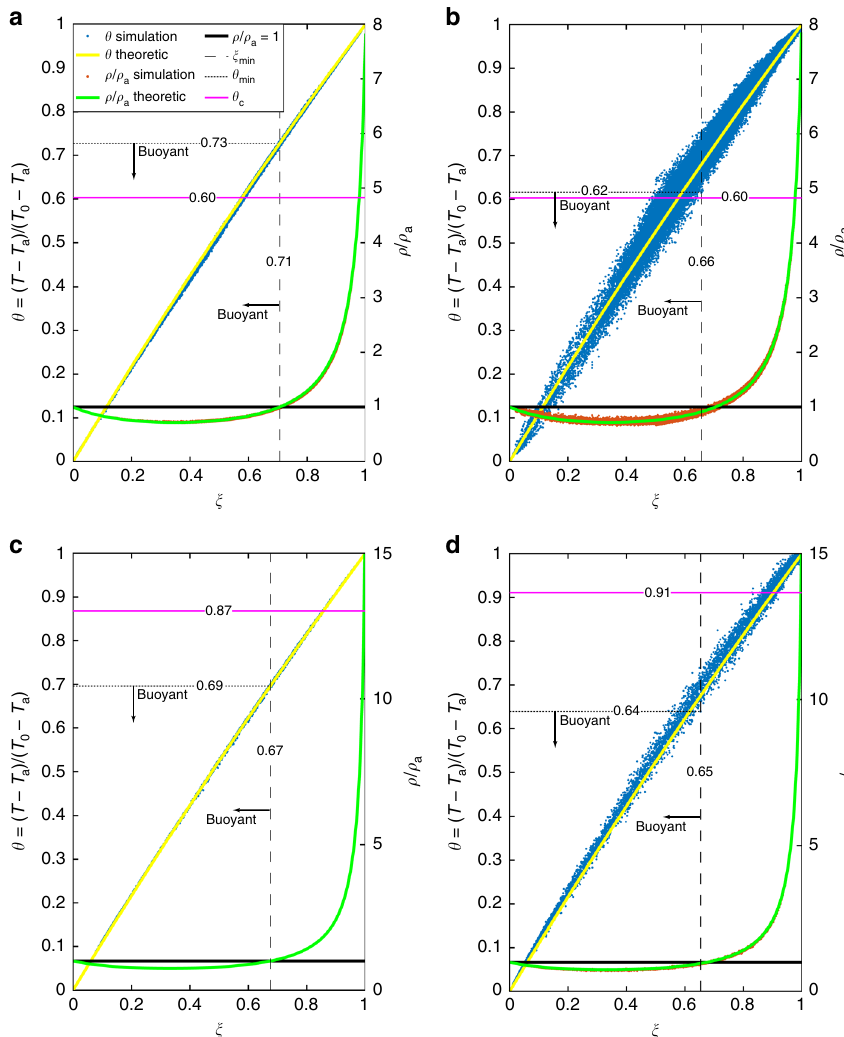
Fig. 2 Thermodynamic properties of the collapse region for the reference models. Dimensionless temperature θ and density ρ / ρ a as a function of erupted material mass fraction ξ in the collapsing region. Blue and red points are extracted from the numerical simulation data (temperature, mass fractions, and density), and the atmospheric temperature in each cell of the collapse region (see Supplementary Fig. 1). Yellow and green solid lines are obtained from Eqs. (1) and (2), using an average atmospheric temperature between the crater and the collapse height. The magenta solid line highlights the nondimensional value of the average temperature of the collapsing region θ c (computed as described in the Methods section), while the black solid line is the level of neutral buoyancy. Black dotted and dashed lines indicate θ min and ξ min , respectively. All the blue points below θ min and all the red points left of ξ min are less dense than the atmosphere at the same height. Panels a and b are for the partial collapse end-member, while c and d are for the total collapse. Panels a and c are for the dusty-gas model, while b and d take into account particle